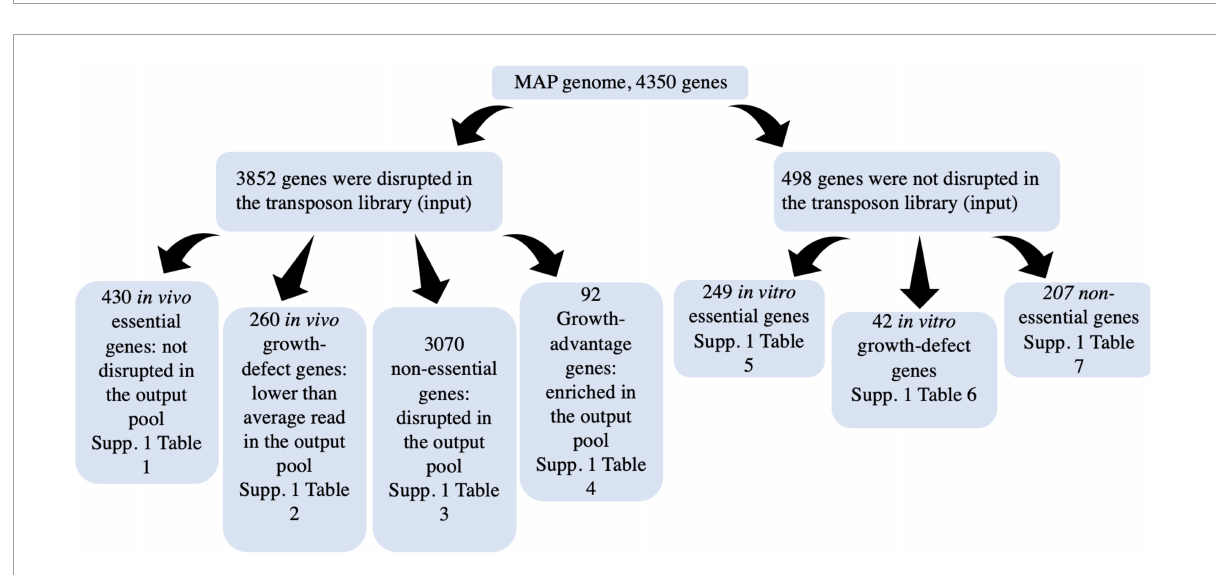
FIGURE4 Distribution of 4,350 genes of MAP genome into different